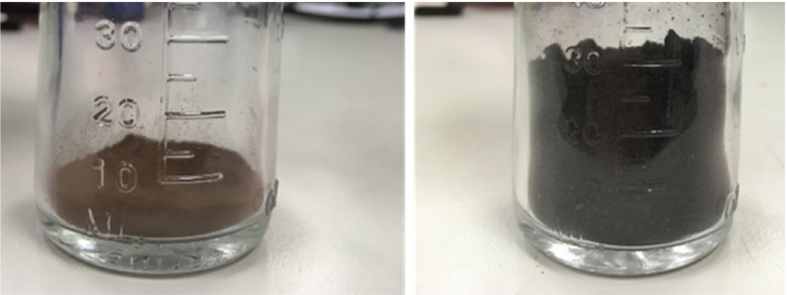
Figure 6. Photos of ( left ) as-received silicon flakes and ( right ) silicon flakes with graphitic nanocar- bon